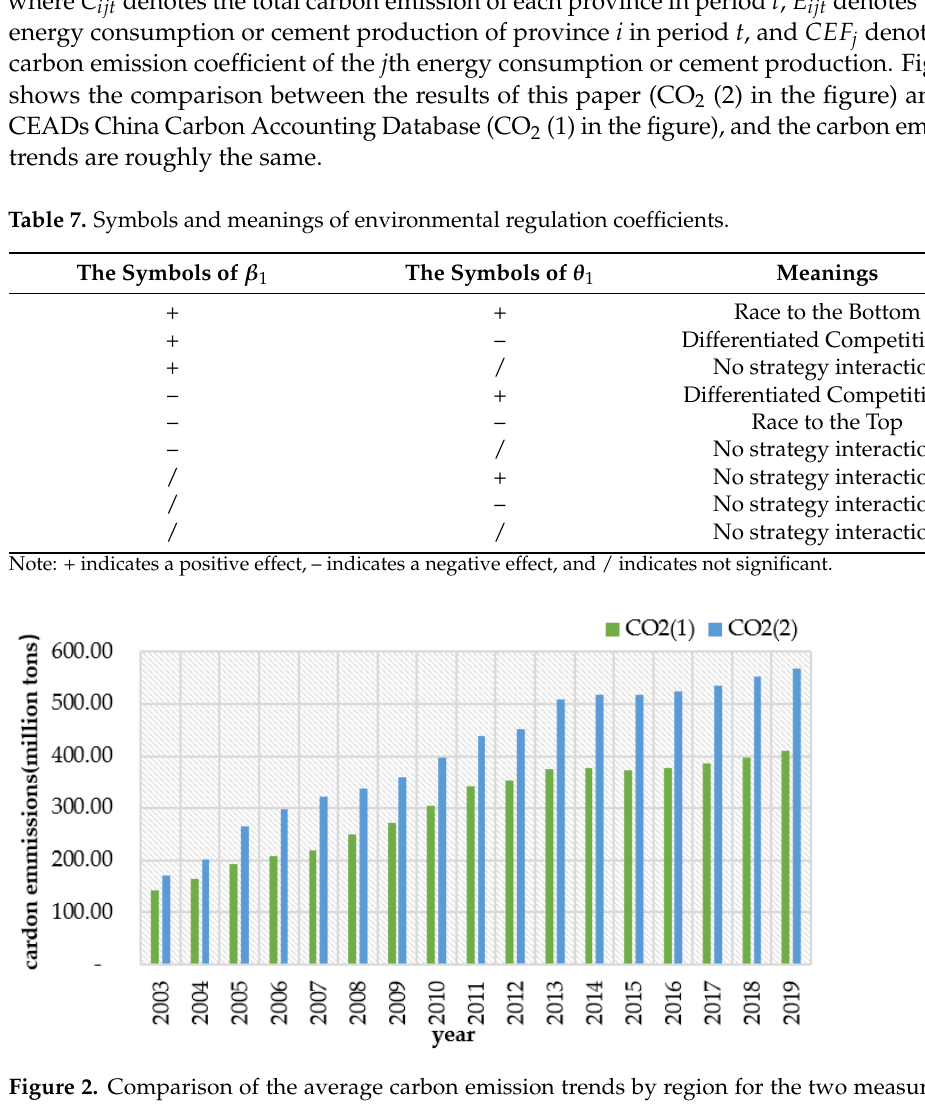
Figure 2. Comparison of the average carbon emission trends by region for the two measurement methods from 2003 to